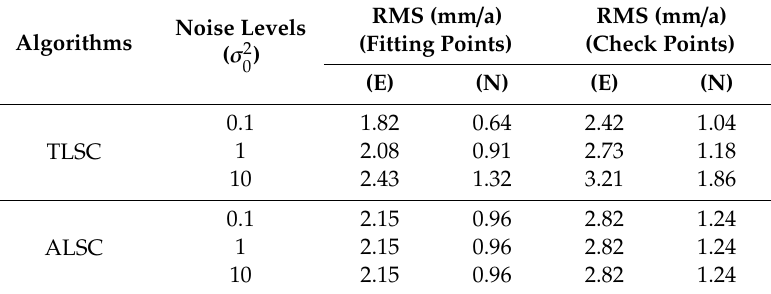
Table 2. Influence of di ff erent noise levels on fitting and estimation results of the traditional LSC algorithm (TLSC) and ALSC algorithms in the actual